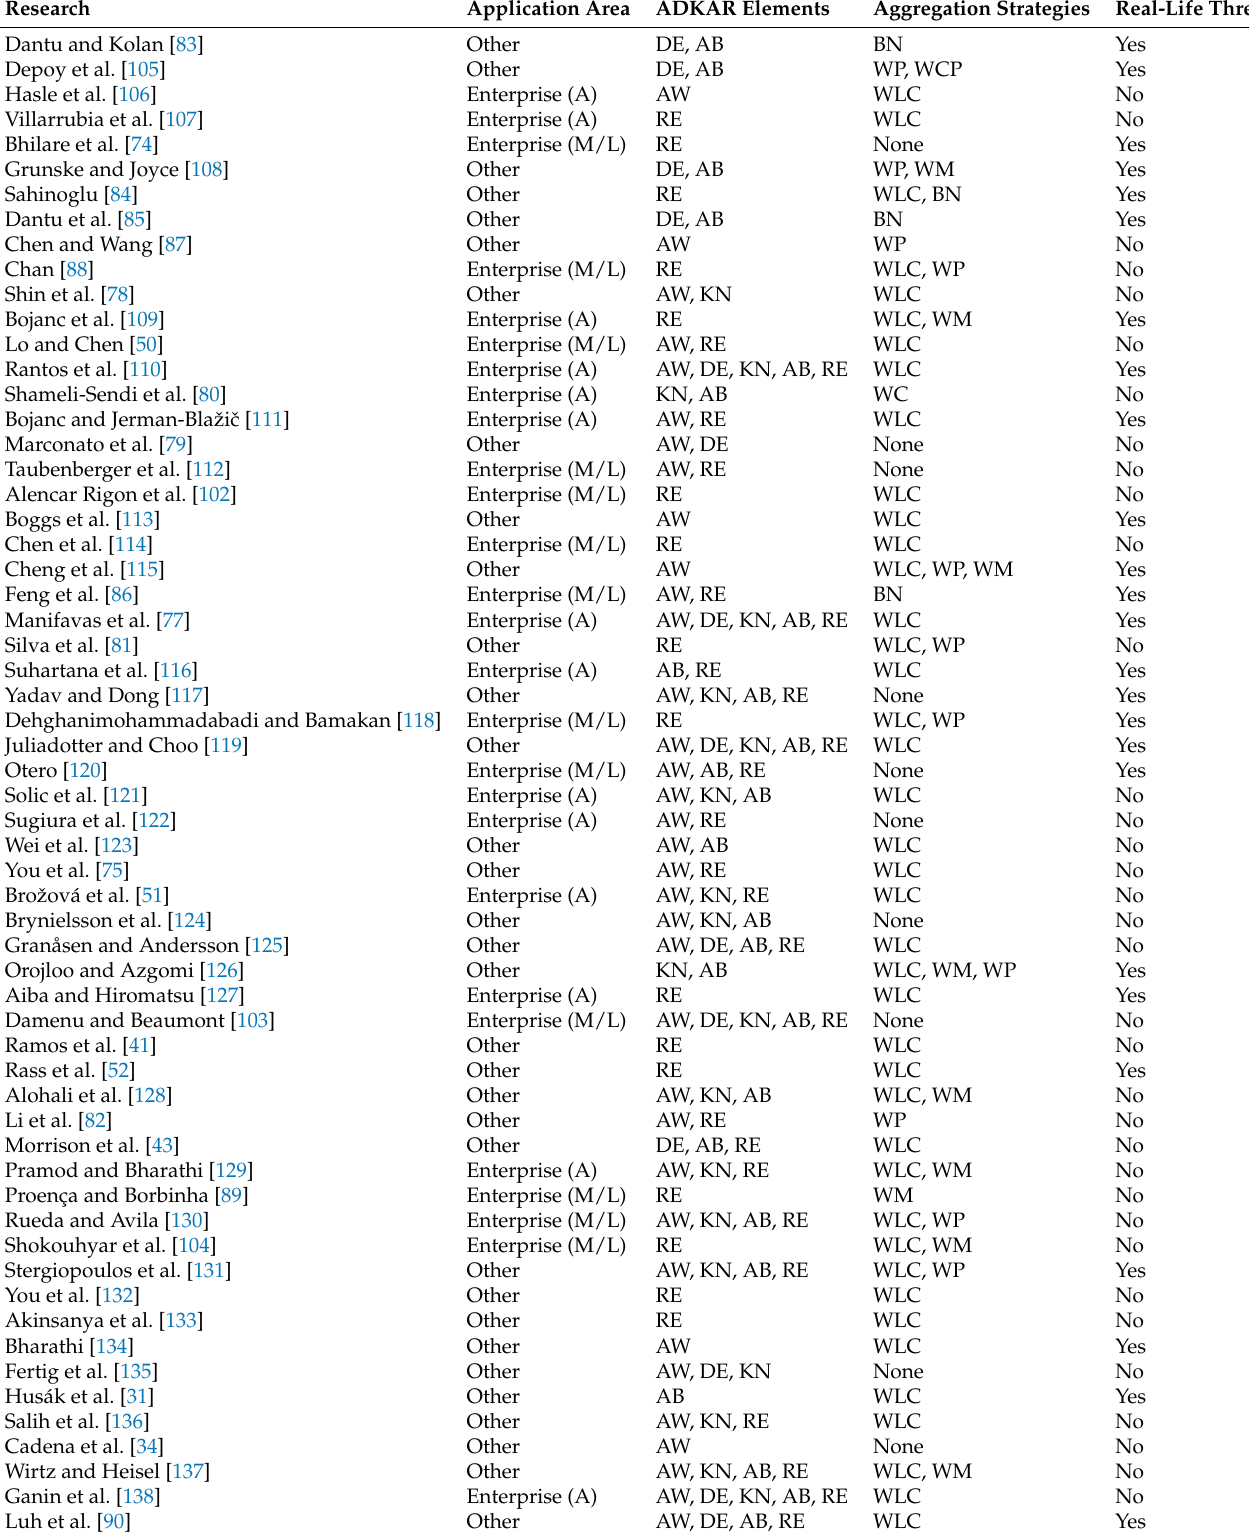
Table A3. The inclusions of our research and a selection of the data items that were presented in this